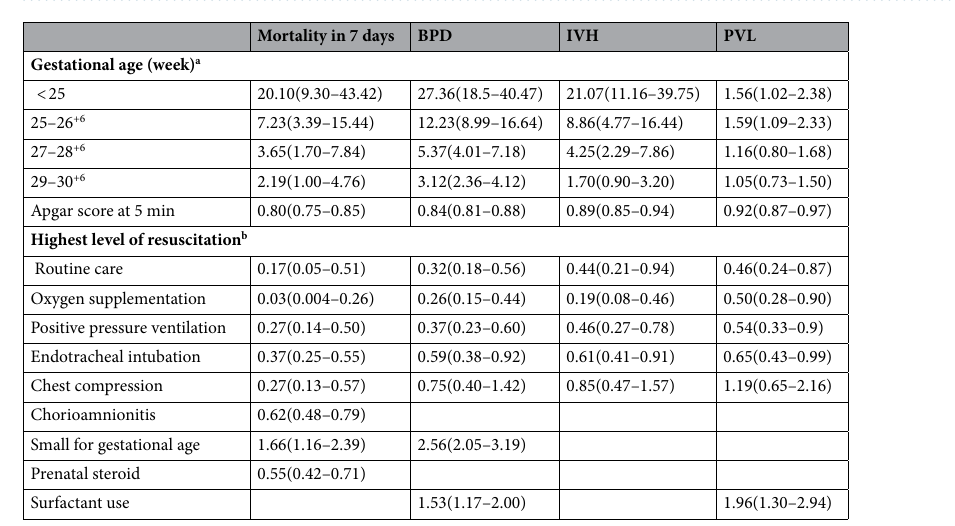
Figure 1. Trends in the highest level of resuscitation in the delivery room. Data are presented as percentage values.